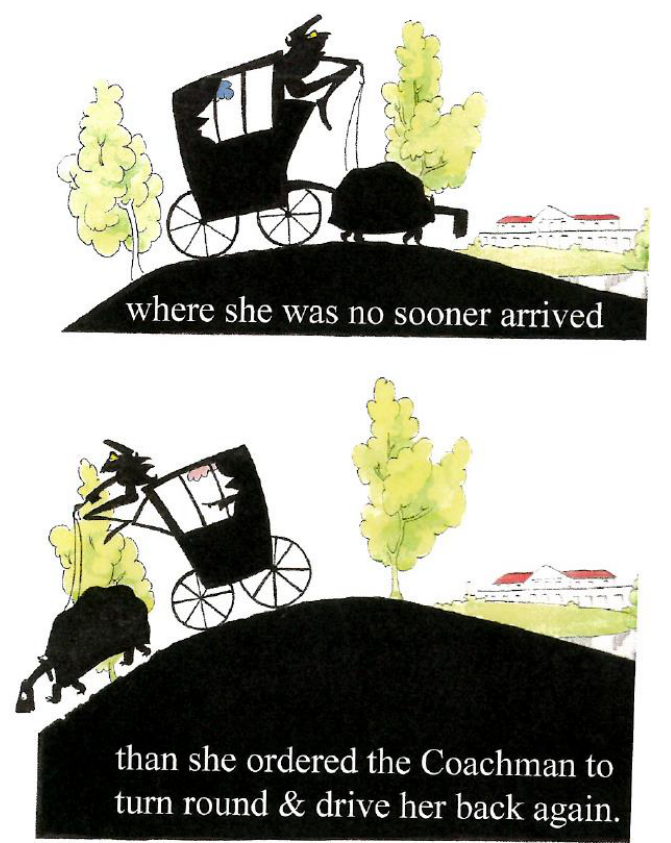
Figure 9. McMaster’s illustration for The Beautifull Cassandra (Austen 2021), p. 16.